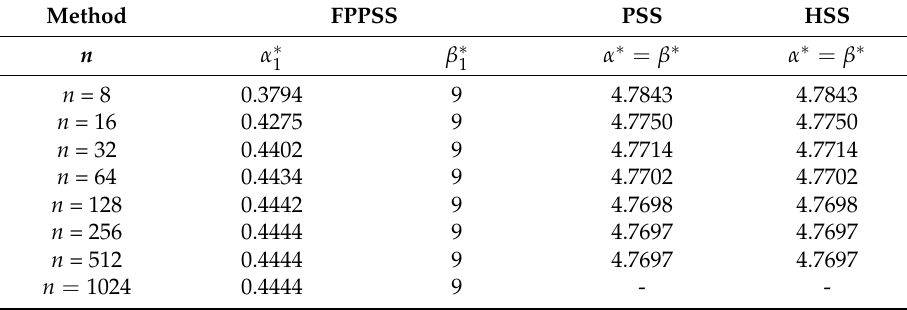
Table 2. The practical optimal value for FPPSS, PSS, and HSS for Example